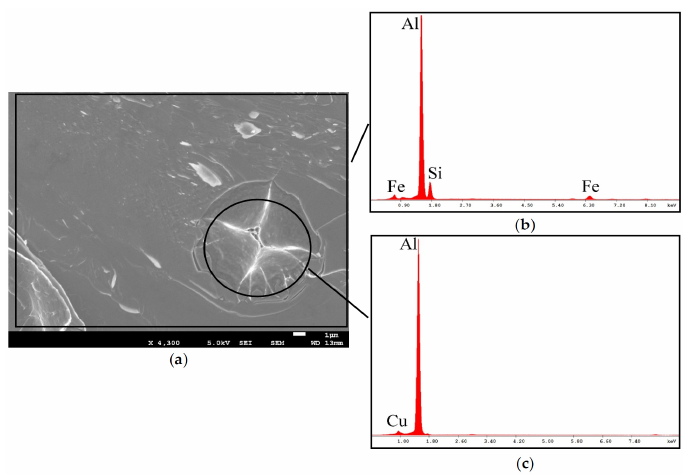
Figure 7. EDS analysis on the fracture surface of Alloy B SDAS 25 showing parts of a β‐ particle in high magnification ( a ). Fe was detected in the ( b ) β‐ particle which were identified together with visual observations. Al and Cu were mainly detected in the ( c ) aluminum dendrite, where dimples have formed in the center due to microvoid coalescence.